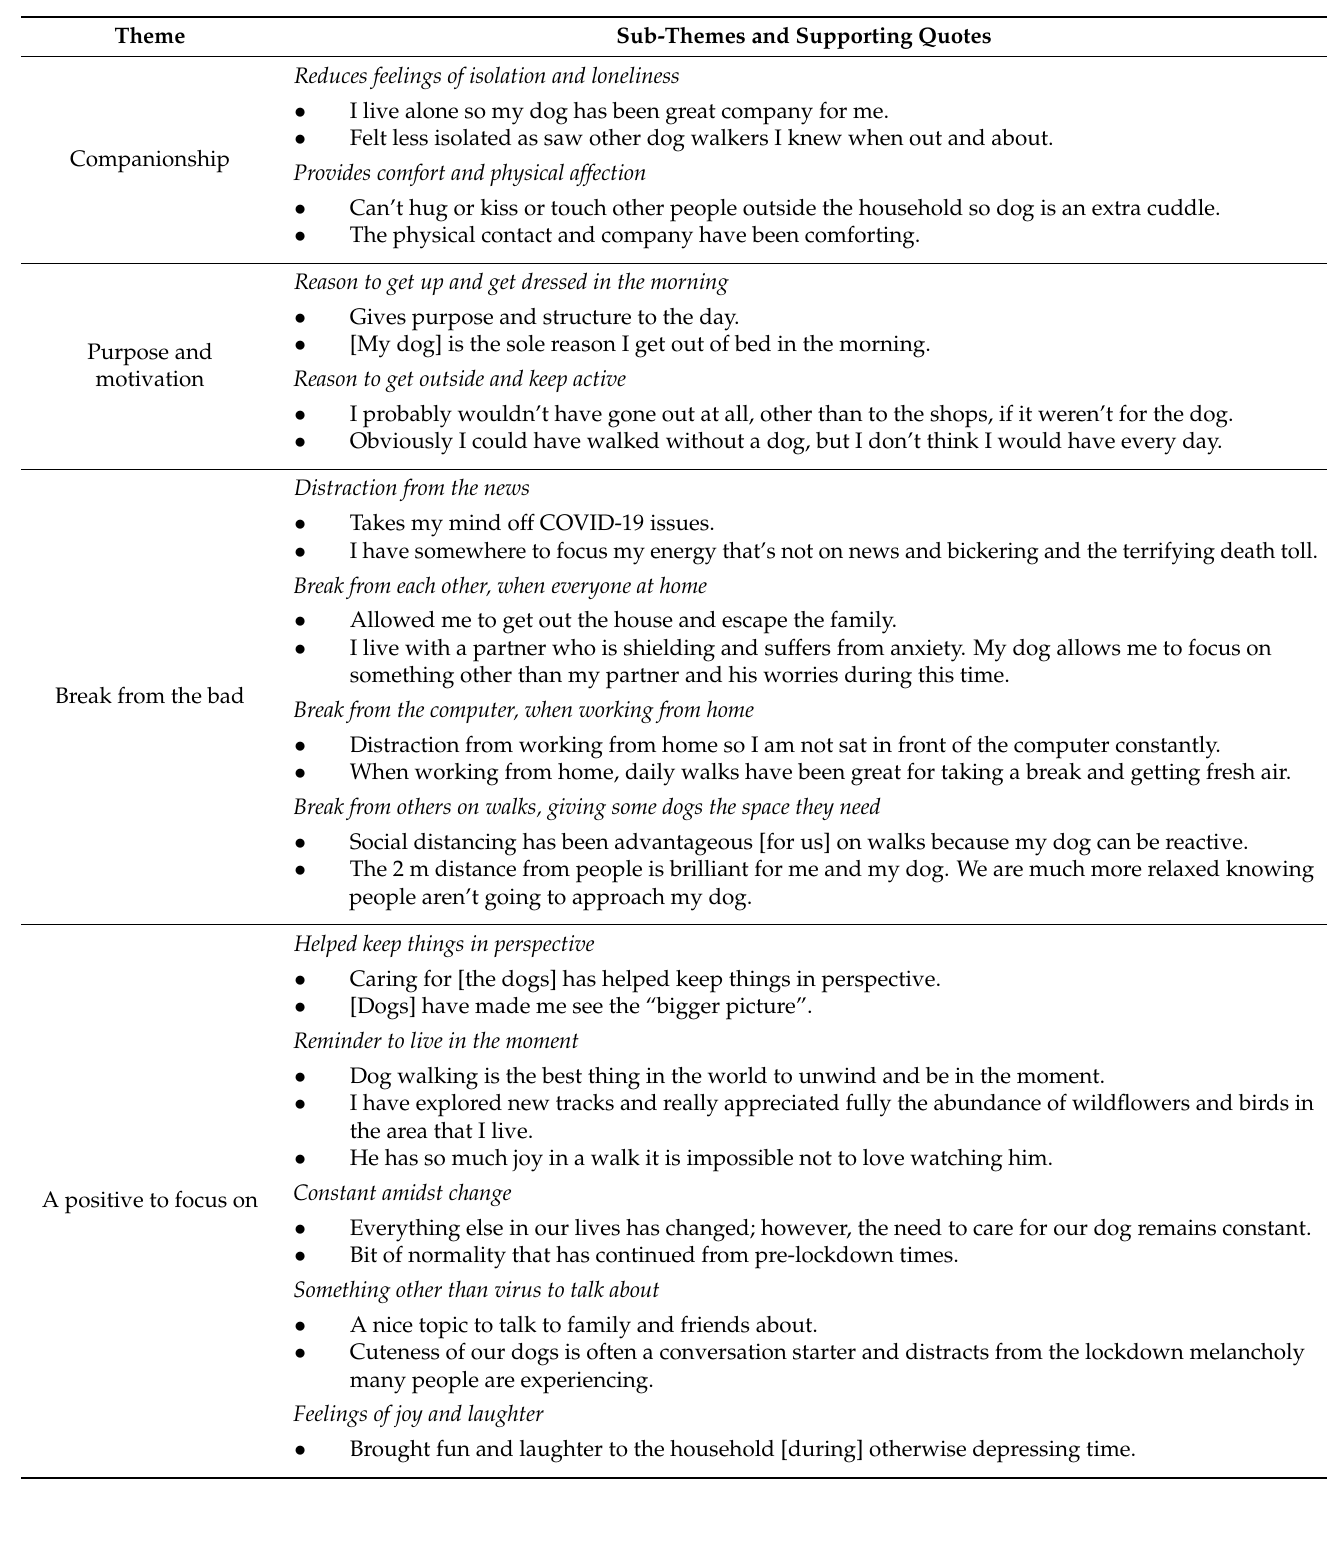
Table 6. Qualitative analysis of respondents answers regarding the benefits of owning and caring for a dog during the COVID-19